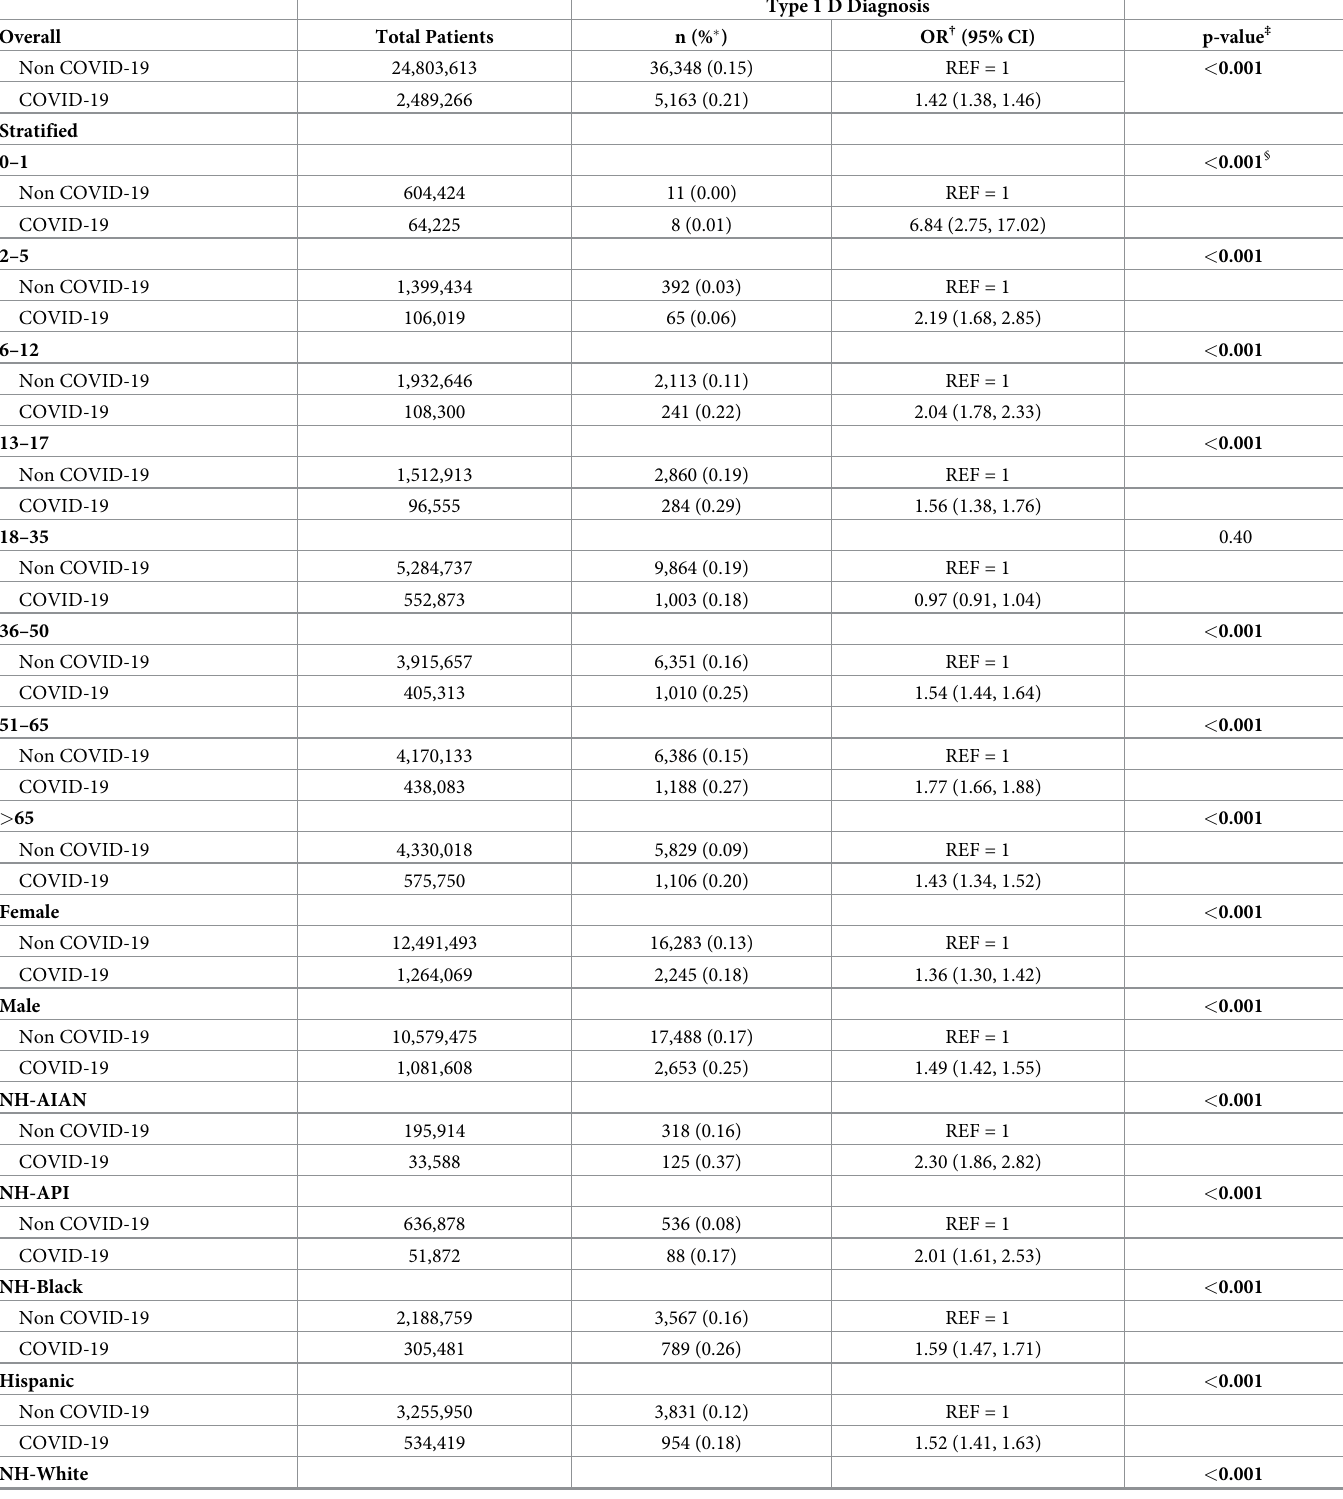
Table 2. Association of COVID-19 diagnosis with incidence of T1D among patients in